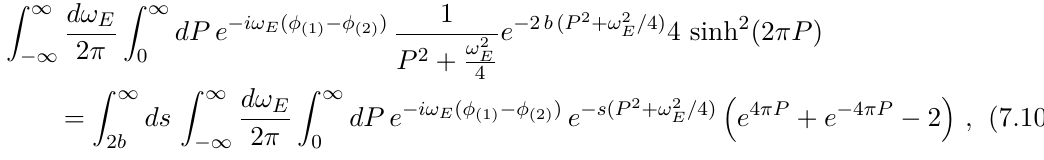
Figure 10 . The closed string contribution to the annulus partition function with different boundary conditions on the two